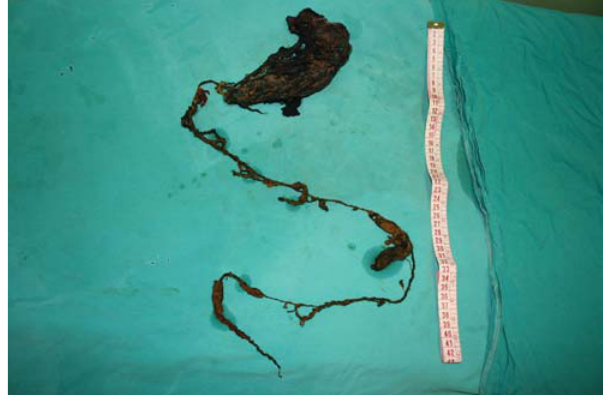
Figure 3 - 86 cm long cotton